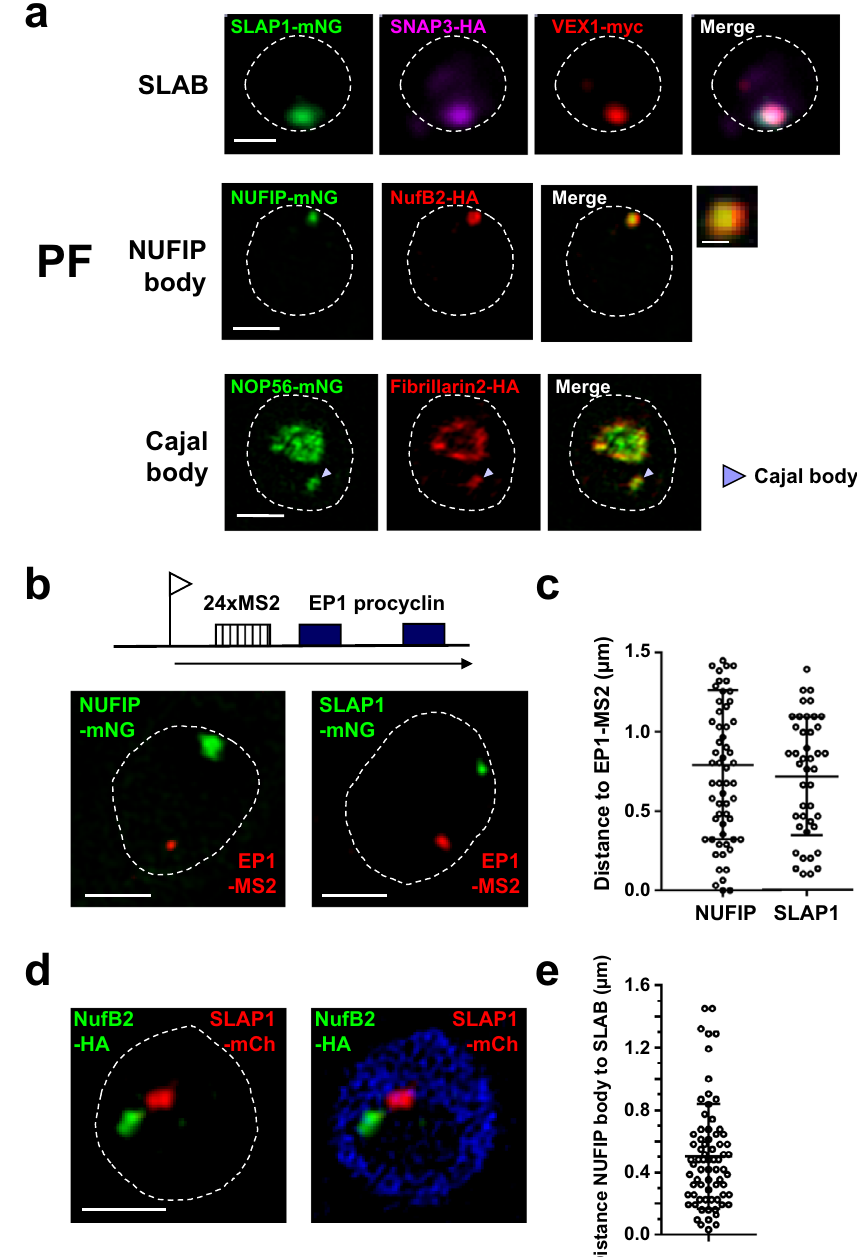
Fig. 9 The SLAB, NUFIP and Cajal bodies are present in PF T. brucei , with the SLAB and NUFIP bodies frequently associated with each other, but not with the EP1 procyclin locus. a The SLAB was investigated using microscopy imaging of a PF T. brucei line expressing the epitope-tagged SLAB components mNG::SLAP1 (SLAP-mNG, green), SNAP3::6HA (SNAP3-HA, magenta) and VEX1::12myc (VEX1-myc, red). The NUFIP body was investigated using SR-SM imaging of a PF cell line expressing epitope-tagged NUFIP body components NUFIP::mNG (NUFIP-mNG, green) and NufB2::6HA (NufB2-HA, red). The inset image shows a magni fi cation of the NUFIP body. The Cajal body was investigated with a PF T. brucei line expressing Cajal body components mNG::NOP56 (NOP56-mNG, green) and 3xHA:: fi brillarin2 ( fi brillarin2-HA, red). The arrowhead indicates the Cajal body. b SR-SIM imaging of RNA-FISH visualising nascent MS2 transcripts expressed from 24 MS2 repeats inserted in the EP1 procyclin locus (EP1-MS2, red) combined with imaging of NUFIP::mNG (NUFIP-mNG) or mNG::SLAP1 (SLAP-mNG, green). A schematic of the EP1 procyclin locus containing MS2 repeats (hatched box) is shown above, with the promoter indicated with a fl ag and transcription with an arrow. c Quantitation of the distance between the NUFIP body (NUFIP) or SLAB (SLAP1) to nascent MS2 transcripts expressed from the EP1 procyclin locus using the PF cells in ( b ). Data were from two biological replicates with error bars indicating ±SD. For EP1-MS2 to SLAP1 n = 43, for EP1-MS2 to NUFIP n = 63. d SR-SIM imaging of a PF T. brucei line expressing epitope-tagged components for the NUFIP: NufB2::6xHA (NufB2-HA, green) or SLAB: mCh::SLAP1 (SLAP1-mCh, red) bodies. e Quantitation of the distance between the NUFIP and SLAB bodies in PF T. brucei using the cell line in ( d ). Data were from two biological replicates with error bars indicating ±SD, n = 72. In all microscopy images, nuclei are indicated with dashed lines and scale bar = 1 μ m for main images and 200 nm for the inset. Source data are provided as a Source Data fi